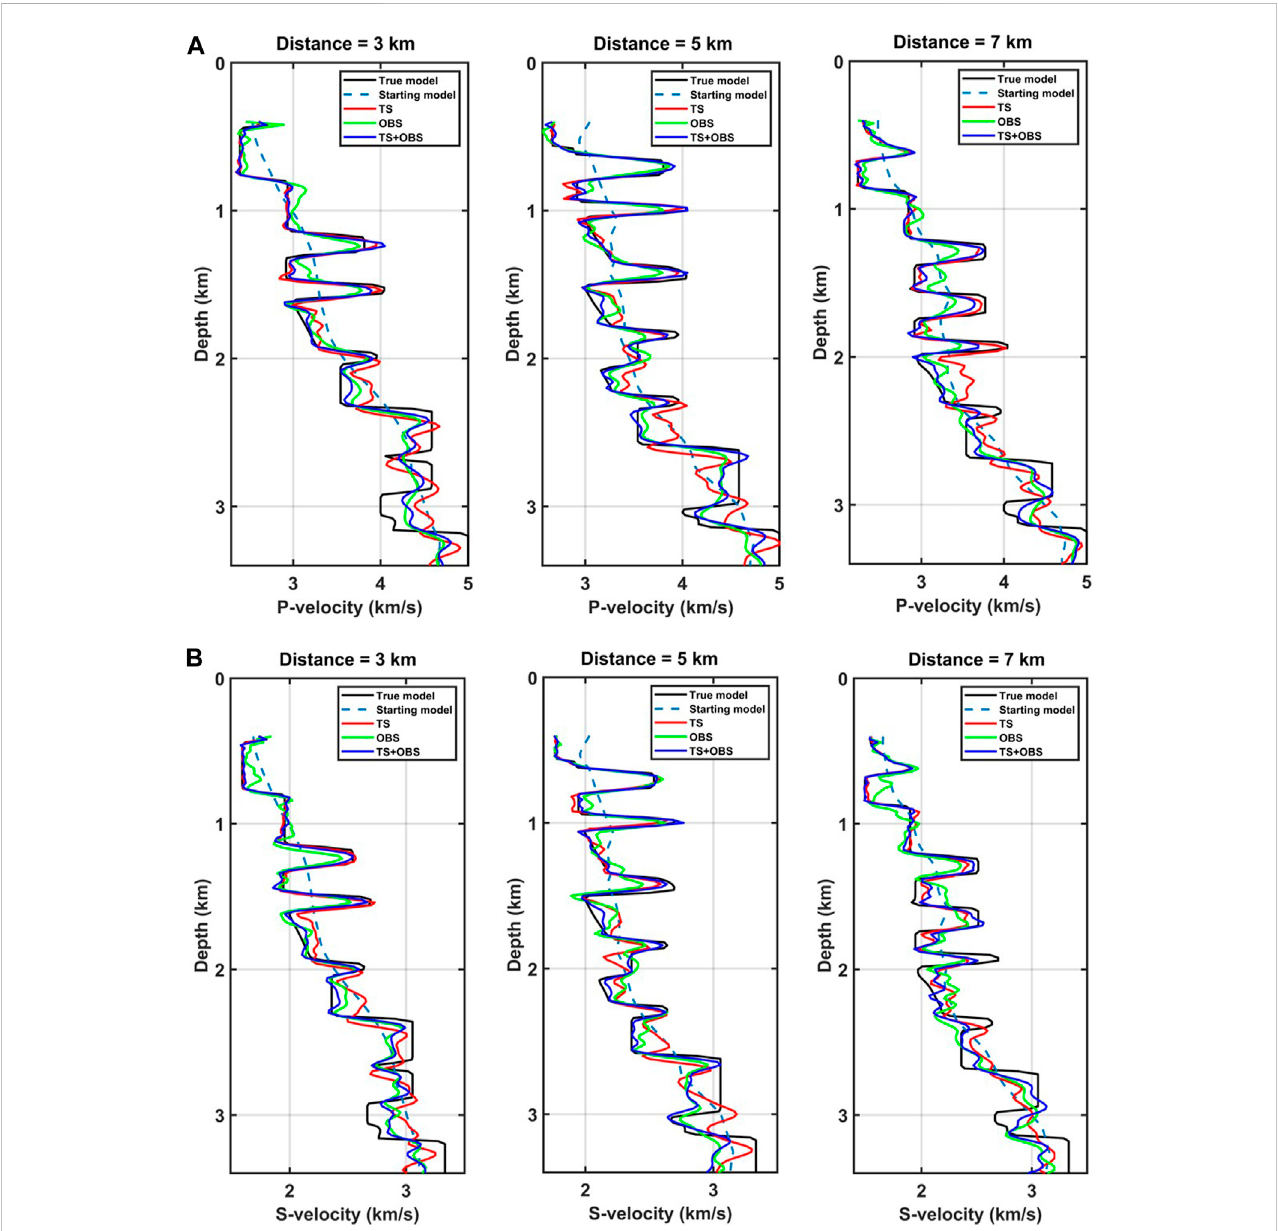
FIGURE 7 Vertical P-wave velocity (A) and S-wave velocity (B) pro fi les at three different locations. The solid black lines indicate the true velocities, the dashed lines indicate the starting velocities, the red lines indicate the results for towed streamer data, the green lines indicate the results for OBS data, and the blue lines indicate the J-AEFWI results.